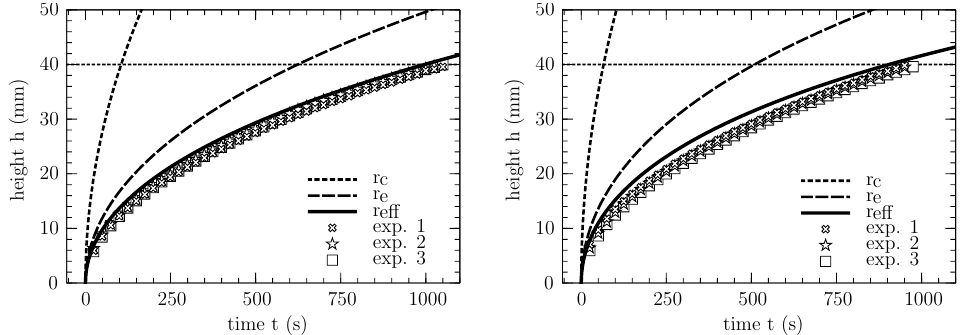
Figure 8. Analytical wicking prediction of three different approaches shown with dashed and solid line and wicking experiments for sample 1 ( right ) and sample 2 ( left ). The typical wicking behavior is presented in a plot in which the height h is plotted over the time t . The experiments were conducted with Porefil ® . The analytical expression is taken from Equation (11), while the properties are taken from Tables 1 and